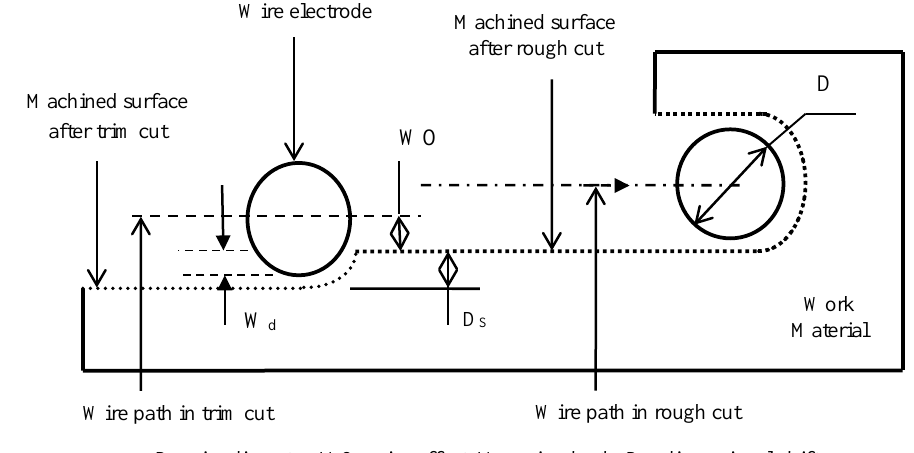
Fig. 2. Terminology used in trim cutting